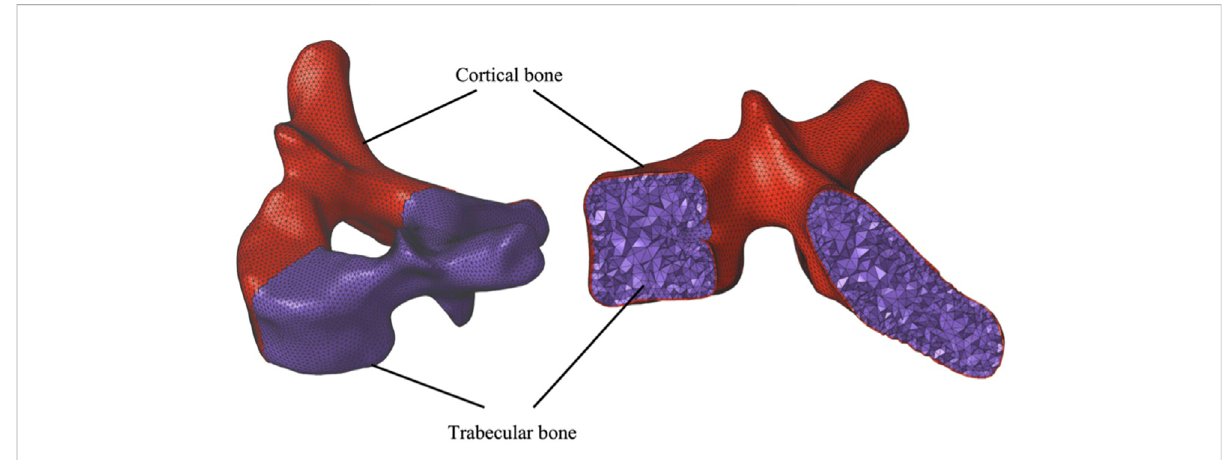
FIGURE 3 Segmentation of the trabecular bone and cortical bone in the